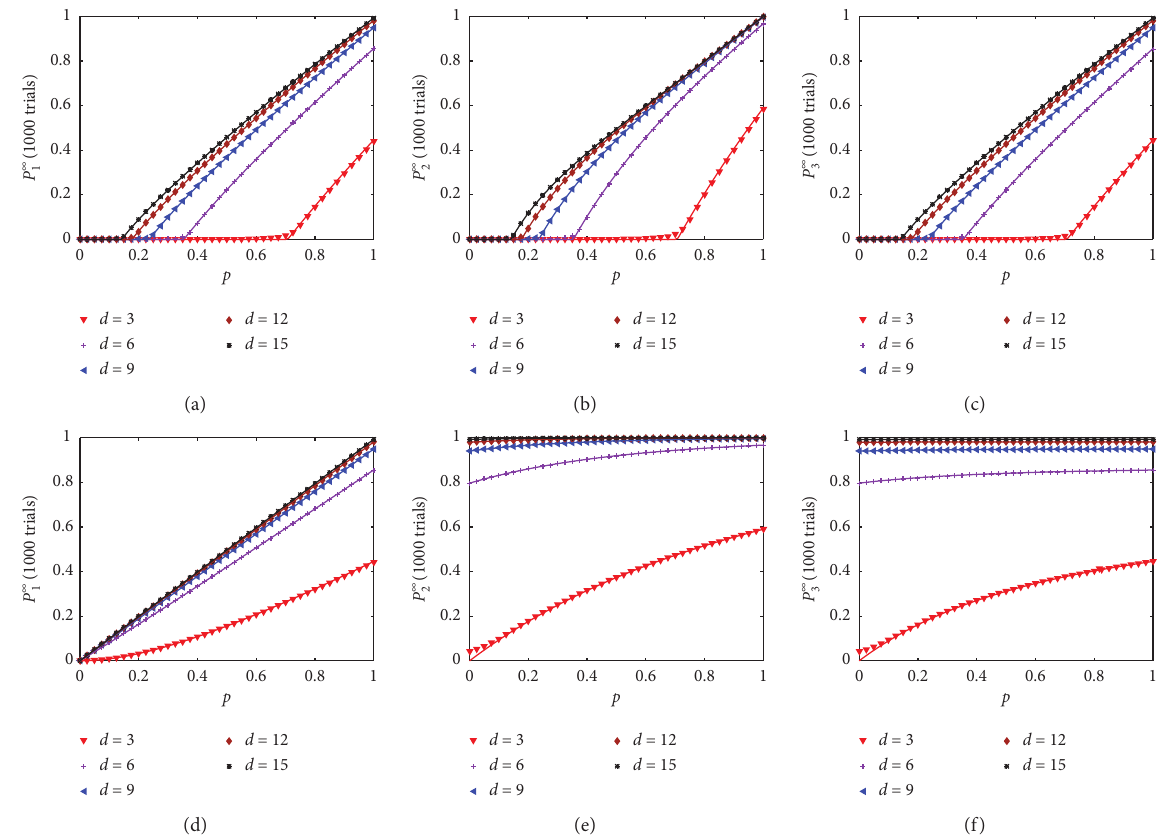
Figure 6: Robustness of tripartite networks based on the global model. Lines denote the theoretical results while symbols represent the simulation results. The first and second rows of the figure, respectively, represent the case that the node removal occurs to S i for all i ∈ [ 1 , 3 ] and for i � 1. Simulation results are averaged over 1000